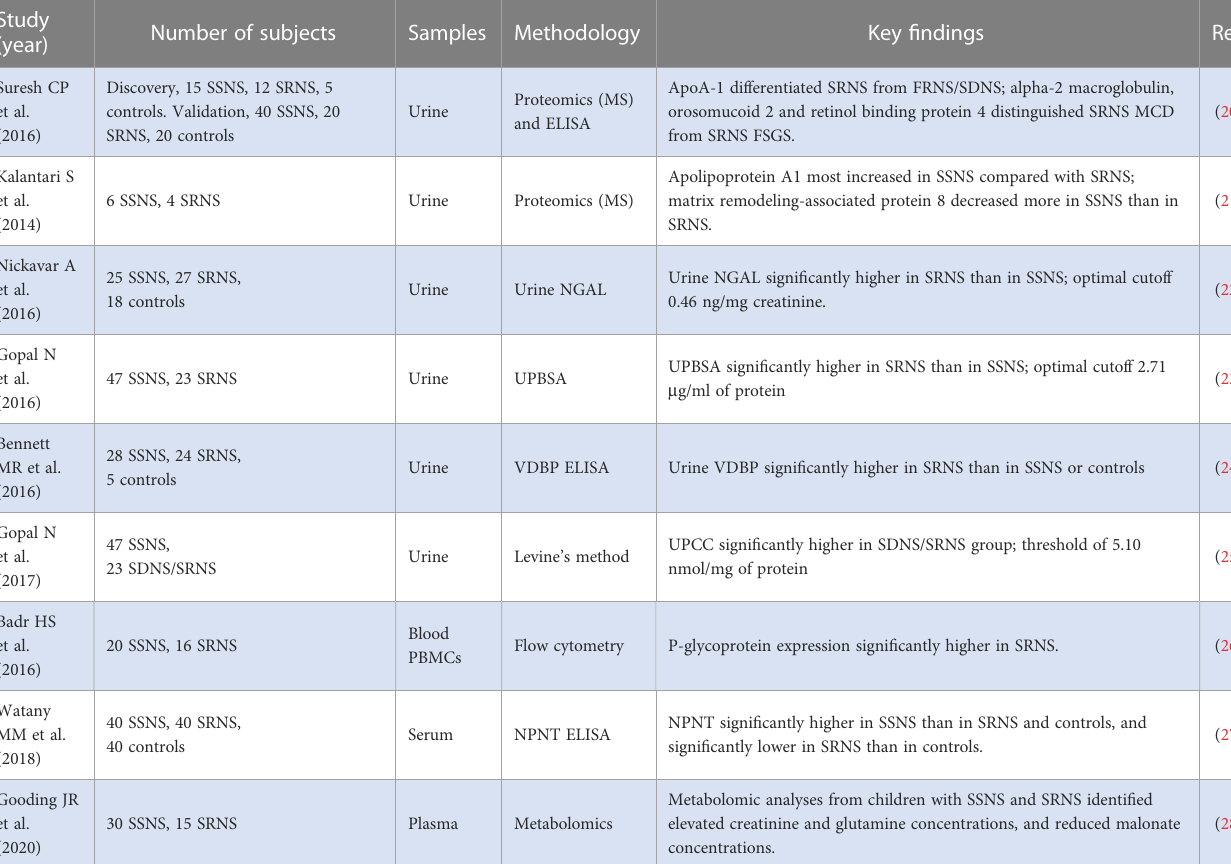
Metabolomic analyses from children with SSNS and SRNS identi fi ed Plasma Metabolomics elevated creatinine and glutamine concentrations, and reduced malonate